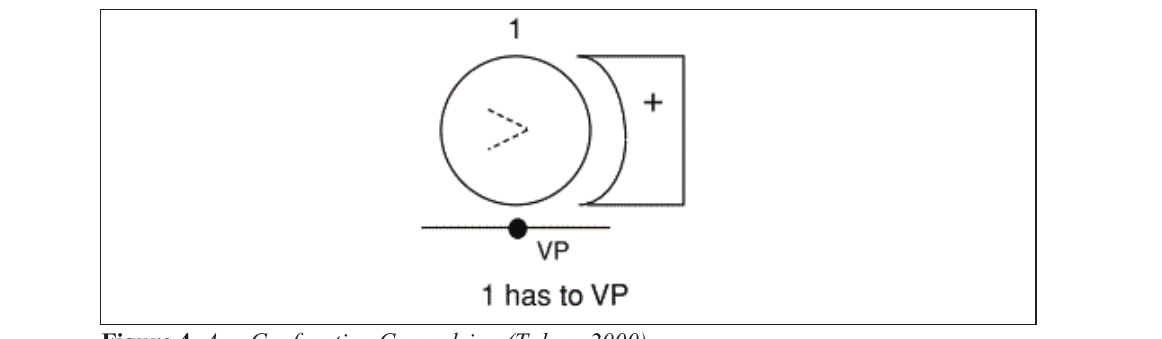
Figure 4. Ago Confronting Compulsion (Talmy, 2000)